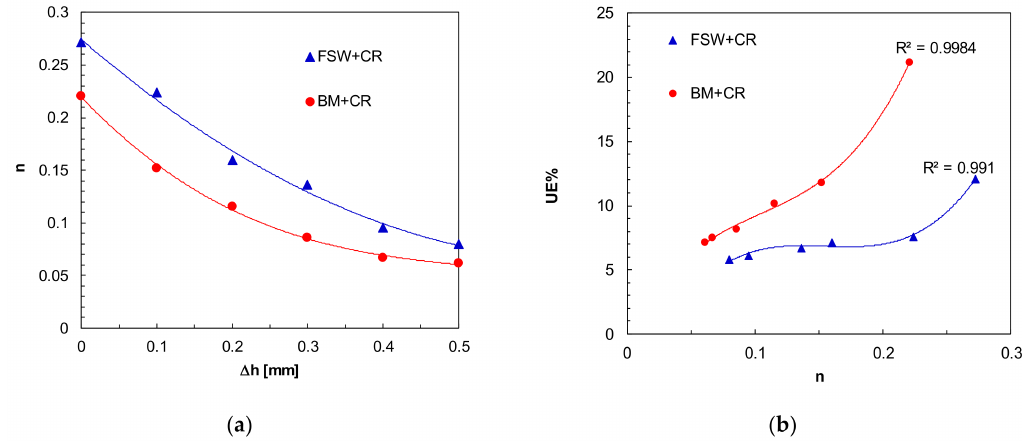
Figure 9. ( a ) Strain hardening exponent vs. height reduction and ( b ) correlation between ultimate elongation and strain hardening exponent in both FSWed+CRed and BM+CRed